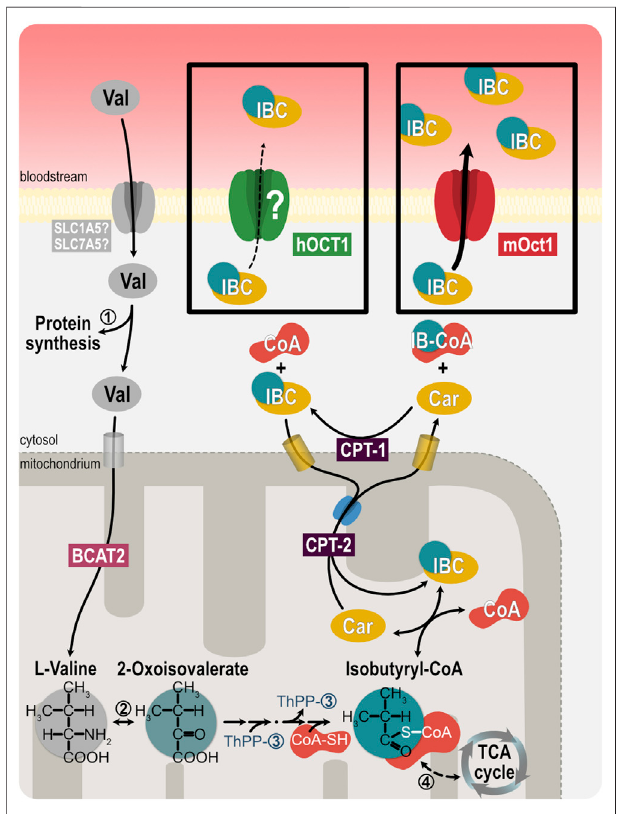
FIGURE 1 | Illustration of isobutyrylcarnitine metabolism. Oxidation of branched-chainaminoacids,suchasvaline,afteruptakeintomitochondriaby SLC25A44andthebranched-chainaminoacidtransaminase2(BCAT2),lead to acylcarnitine intermediates, such as isobutyrylcarnitine. Exchange of carnitineandacylcarnitinesacrossmitochondrialmembranesexportstheacyl residues into the cytosol. ➀ valyl tRNA ligase, ➁ branched-chain amino acid transaminase, ➂ 3-methyl-oxo-butanoate dehydrogenase, ➃ acyl-CoA dehydrogenase, CPT-1 carnitine-palmitoyltransferase 1, CPT-2 carnitine- palmitoyltransferase